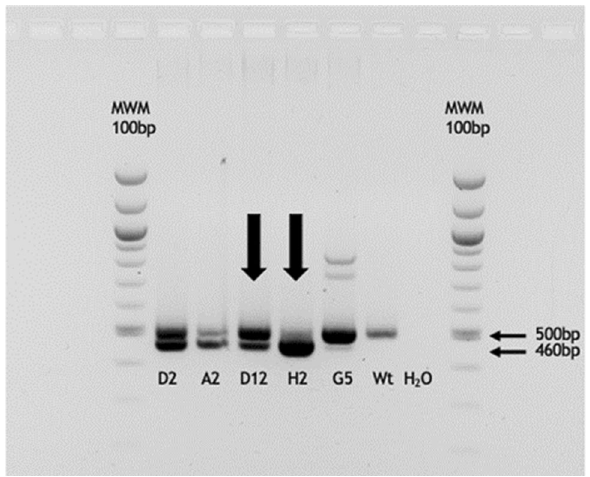
Figure 3. PCR analysis of the TRDC locus of CRISPR/Cas9 transfected cells. The lower band of 460 bp indicates a 40 bp deletion caused by the CRISPR/Cas9 construct. Cell clone D12 displayed two bands of 500 bp and 460 bp of size which indicates a mixed population of cells consisting of TRDC-knockout cells, wild type cells and/or cells with a monoallelic knockout of the TRDC locus. In contrast, cell clone H2 shows a single band of 460 bp indicating an almost pure population of TRDC knockout cells.